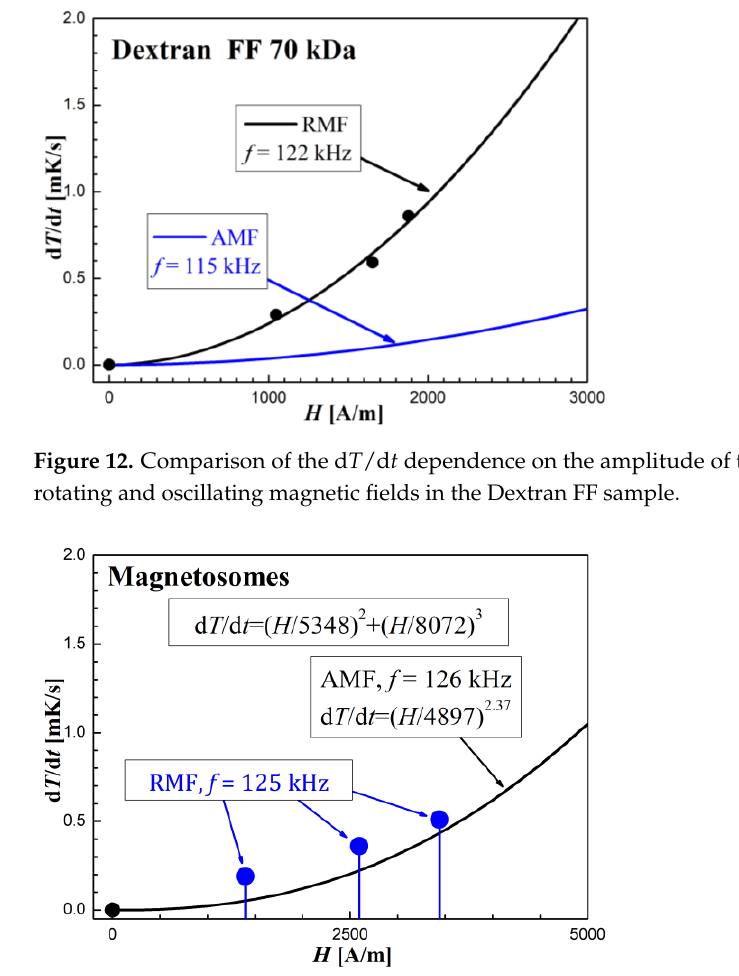
Figure 13. Comparison of the d T /d t dependence on the amplitude of the intensity H measured in rotating and oscillating magnetic field in the Magnetosomes sample.